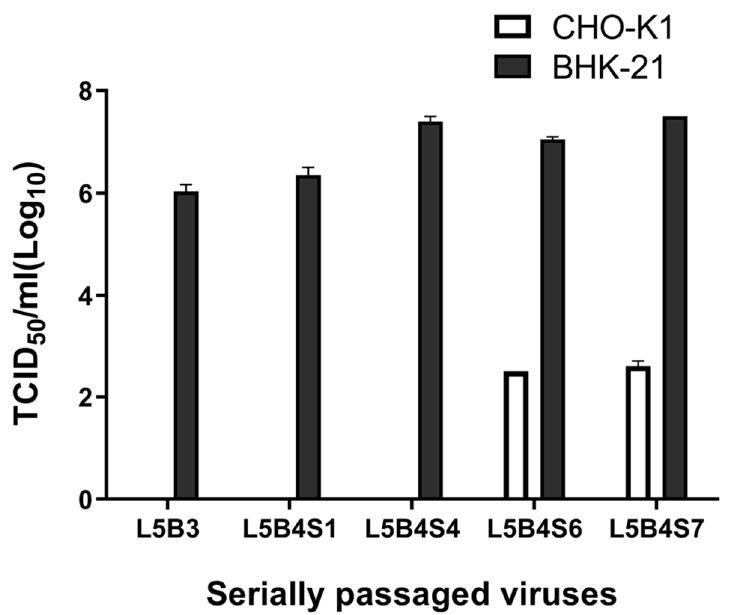
Figure 1. Cell adaptation of A/SKR/Yeoncheon/2017 over serial passages. Foot-and-mouth disease virus (FMDV) A/SKR/Yeoncheon/2017 was serially passaged as follows for adaptation to the cells: five times in porcine kidney (LFBK) cells and three times in baby hamster kidney (BHK)-21 adherent cells (L5B3); five times in LFBK cells, four times in BHK-21 adherent cells, and one time in BHK-21 suspension cells (L5B4S1); five times in LFBK cells, four times in BHK-21 adherent cells, and four times in BHK-21 suspension cells (L5B4S4); five times in LFBK cells, four times in BHK-21 adherent cells, and six times in BHK-21 suspension cells (L5B4S6); five times in LFBK cells, four times in BHK-21 adherent cells, and seven times in BHK-21 suspension cells (L5B4S7). The 50% tissue culture infective dose (TCID 50 ) of the virus during passaging was measured in BHK-21 adherent cells expressing the integrin receptor and in CHO-K1 cells expressing the heparan sulfate (HS) receptor. Error bars indicate standard deviations (SDs) from the mean.